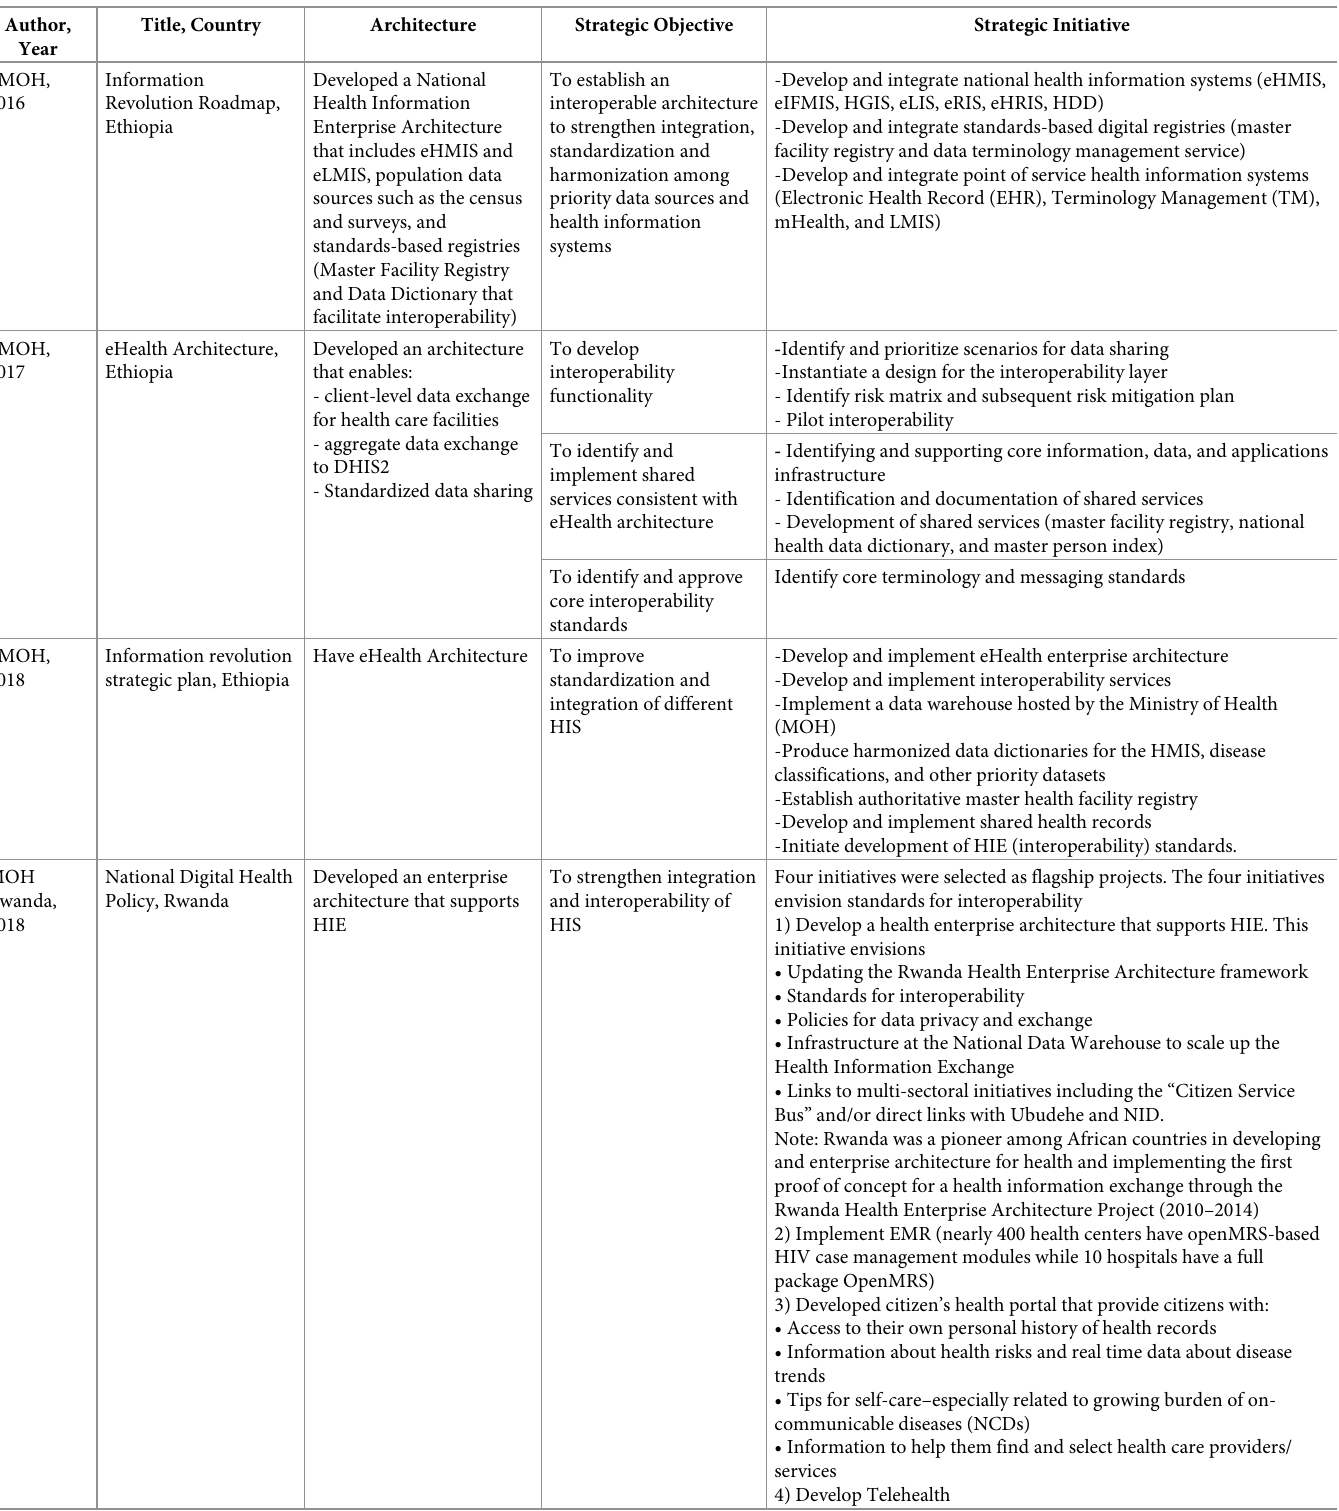
Table 2. Architecture, strategic objectives, and strategic initiatives of reviewed